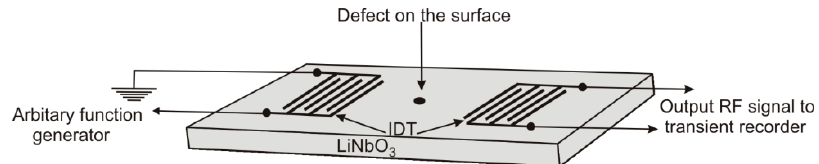
Figure 2. A schematic representation of the IDT experiments for damage detection in Lithium Niobate (LiNbO 3 ) crystal.